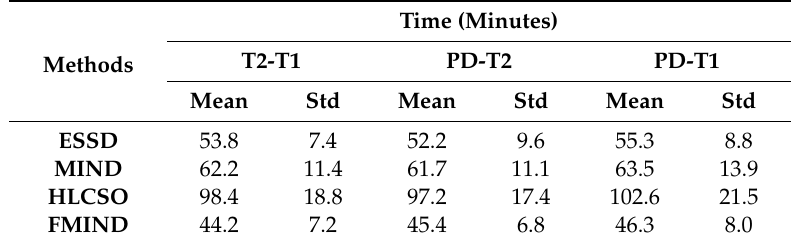
Table 2. Computation time for all evaluated methods operating on the T2-T1, PD-T2, and PD-T1 image pairs.